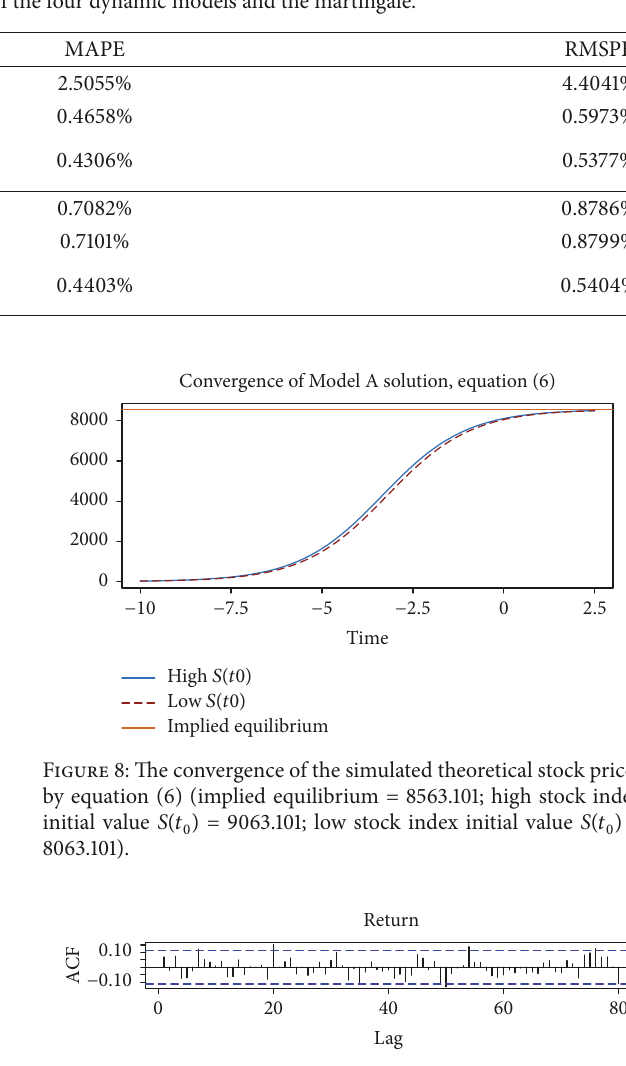
Table 3: MAPEs and RMSPEs, forecasts of the four dynamic models and the martingale.